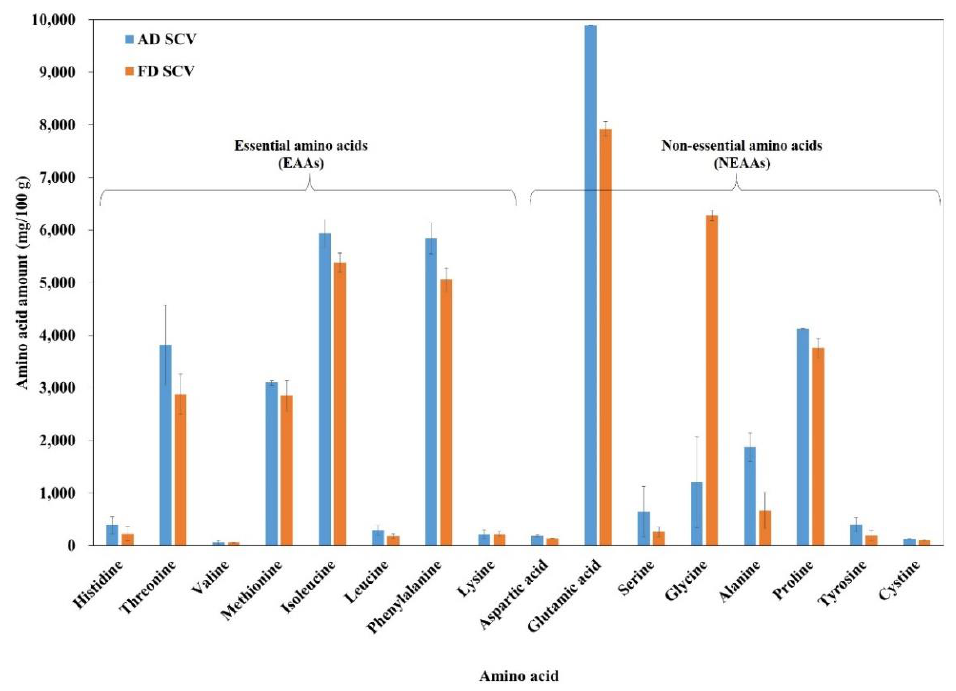
Figure 8. Amino acid composition of air-dried (AD SCV) and freeze-dried (FD SCV) sea cucumber viscera.